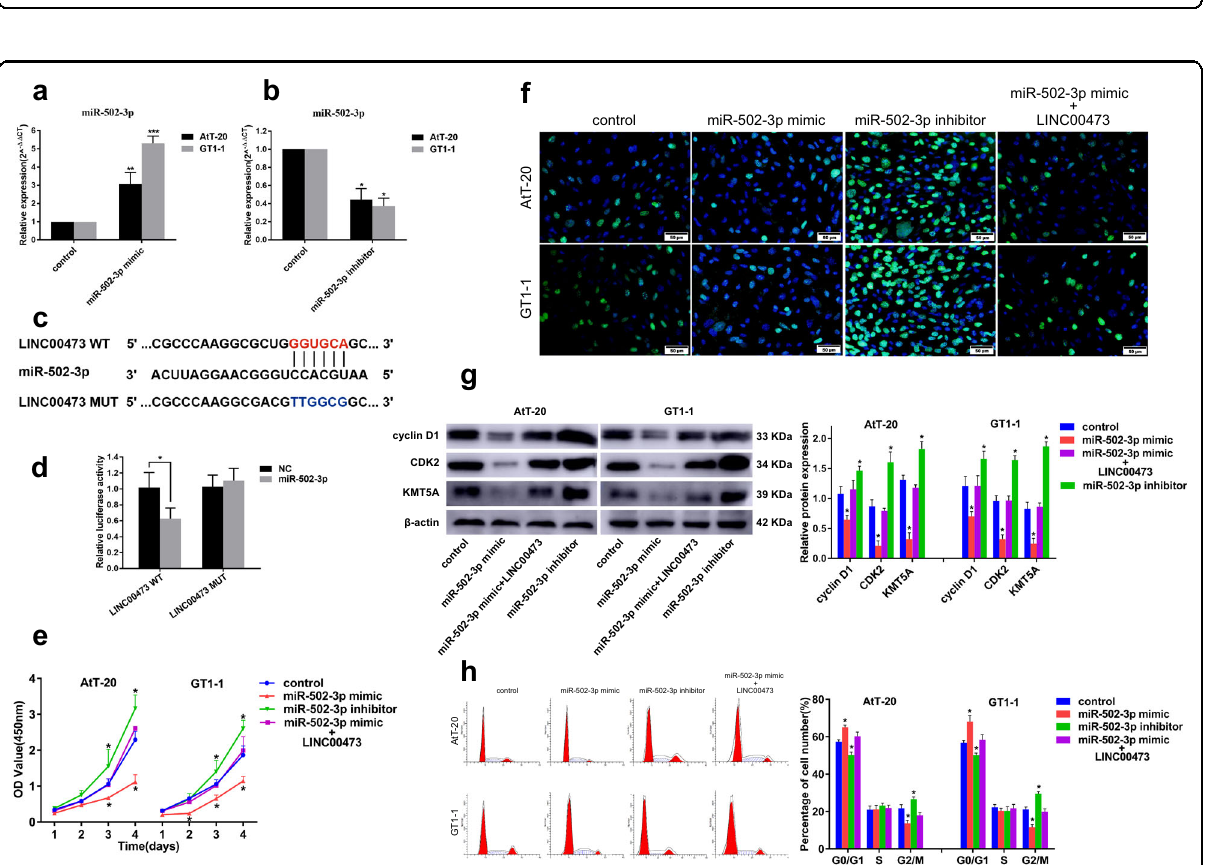
Fig. 4 LINC00473 counteract the inhibitory effect of miR-502-3p on PA cells proliferation. qRT-PCR detection of miR-502-3p mimic ( a ) and inhibitor ( b ) transfection ef fi ciency in PA cells AtT-20 and GT1-1. c Prediction of binding sites for LINC00473 and miR-502-3p, wide type and mutant type of LINC00473 were designed for luciferase reporter assay. d Dual luciferase reporter gene assay was used to detect the binding ability between LINC00473 and miR-502-3p. e CCK-8 detection of PA cells viability after transfection of miR-502-3p mimic, inhibitor or co-transfection of miR-502-3p mimic and pcDNA 3.1( + )-LINC00473. f Cell proliferation was determined by EdU staining. g Western blot analysis of cyclin D1, CDK2, and KMT5A expression. h Cell cycle was analyzed by fl ow cytometry. * P < 0.05, ** P < 0.01, *** P < 0.001, data represent the mean ±